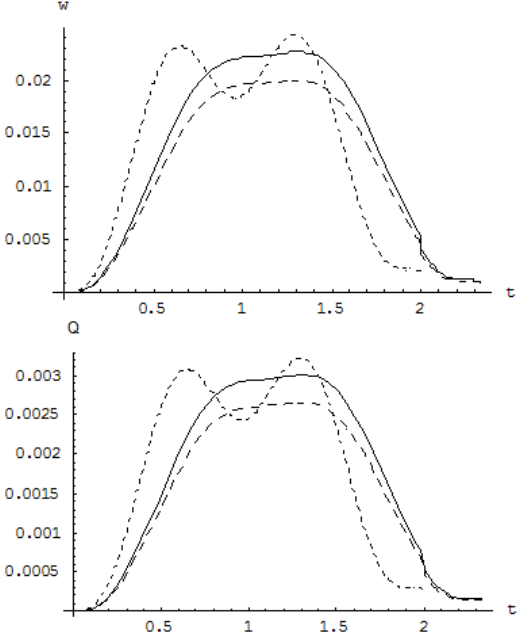
Figure 26: The vertical-torsional motion of the middle of the bridge (at x = L /2 ), for R = 150 m, υ = 30 m/s, e H = 3.00 m, e V = 1.20 m and three models of loading ( __ ) the real vehicle, (- - -) consequence of two loads, ( .... ) one concentrated load.